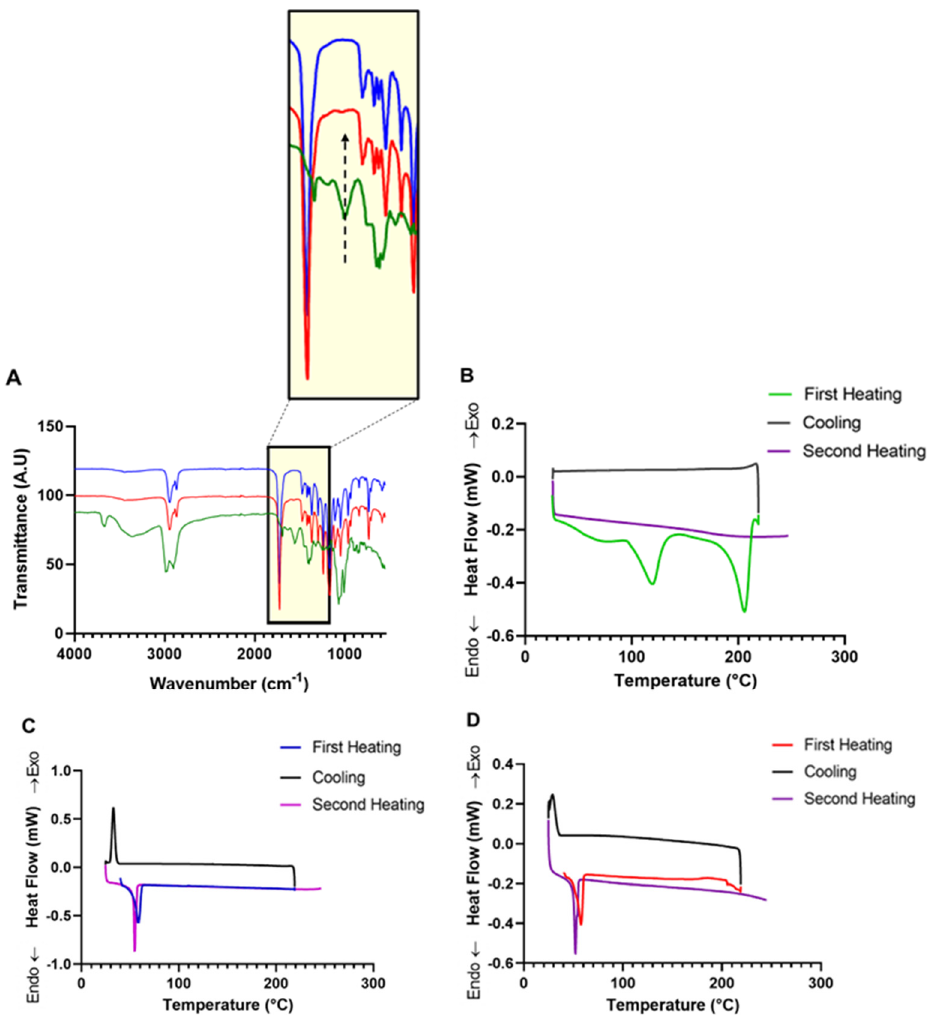
Figure 3. FTIR spectra of AMB (green line), PCL-AMB NPs (red line), and PCL NPs (blue line), black arrow highlights AMB C=C stretch in polyene in the PCL-AMB NPs spectra ( A ). DSC curves of AMB ( B ), PCL NPs ( C ) and PCL-AMB NPs ( D ).